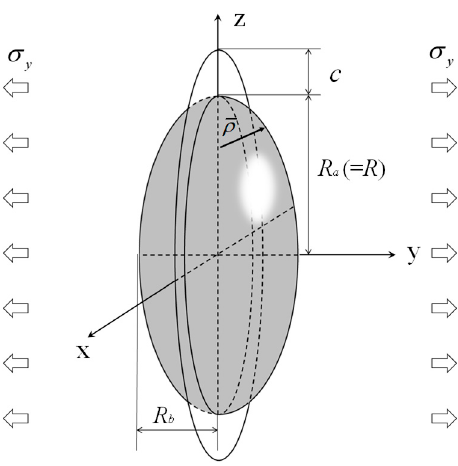
Figure 2. Schematic of the circumferential circular crack emanating from an ellipsoidal pore. The radius in the y-direction is the same as R .